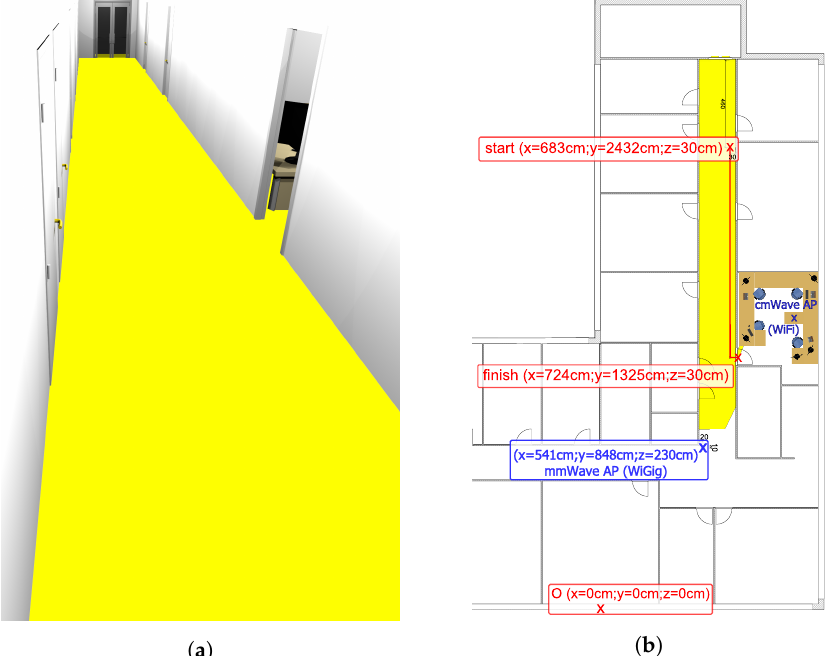
Figure 3. Test scenario 3D model and layout. ( a ) The 3D model of the corridor. ( b ) Test scenario layout combined with LoS